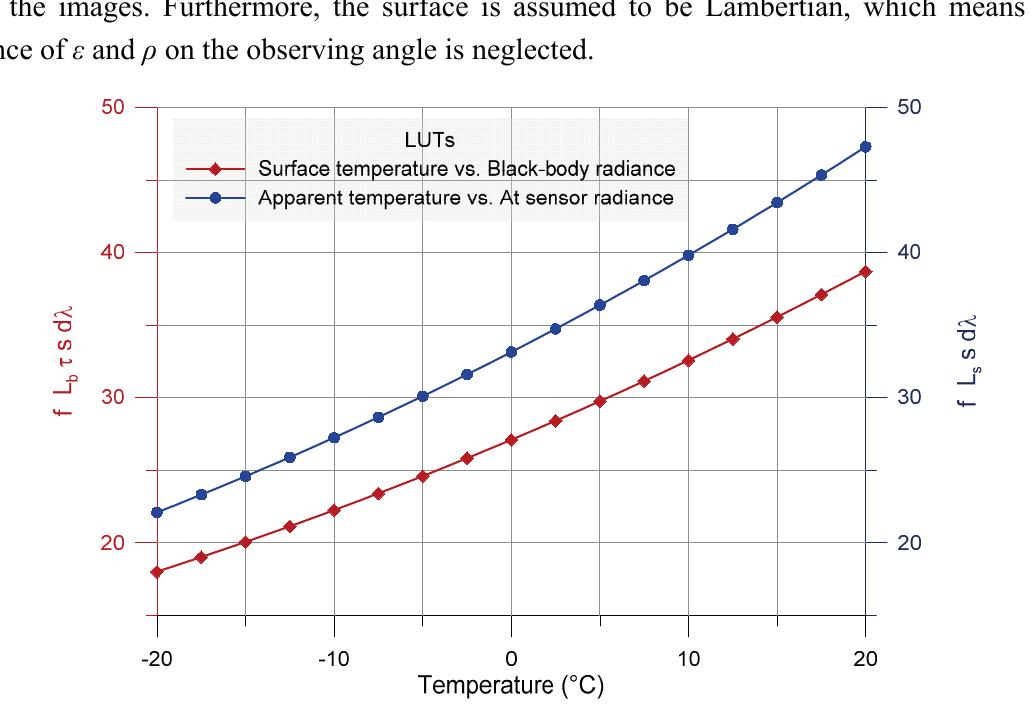
Figure 1. Plot of the look-up tables used to model the relations between the surface temperature and the black-body radiance (red line with diamonds, left vertical axis) and between the apparent temperature and the radiance at sensor (blue line with circles, right vertical axis). Vertical axes are in units of W/m 2